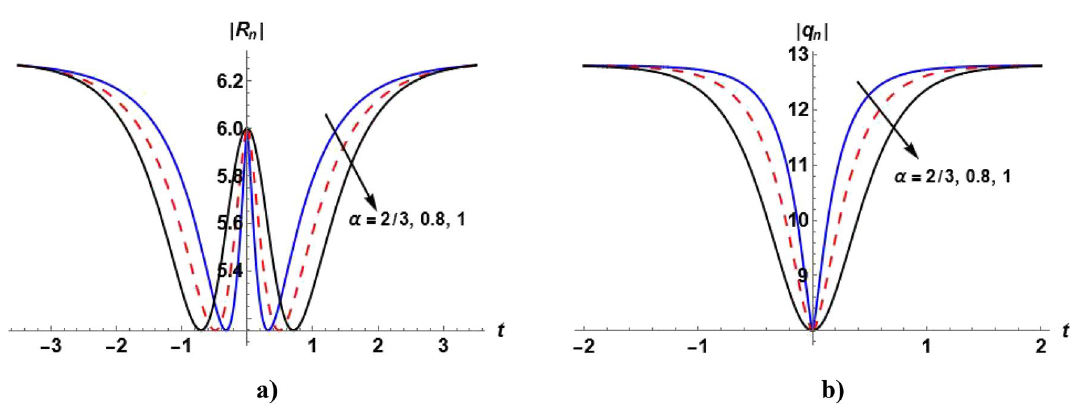
Figure 3. Plot of the solutions (32) and (33) when c 1 values of n for different values of α .